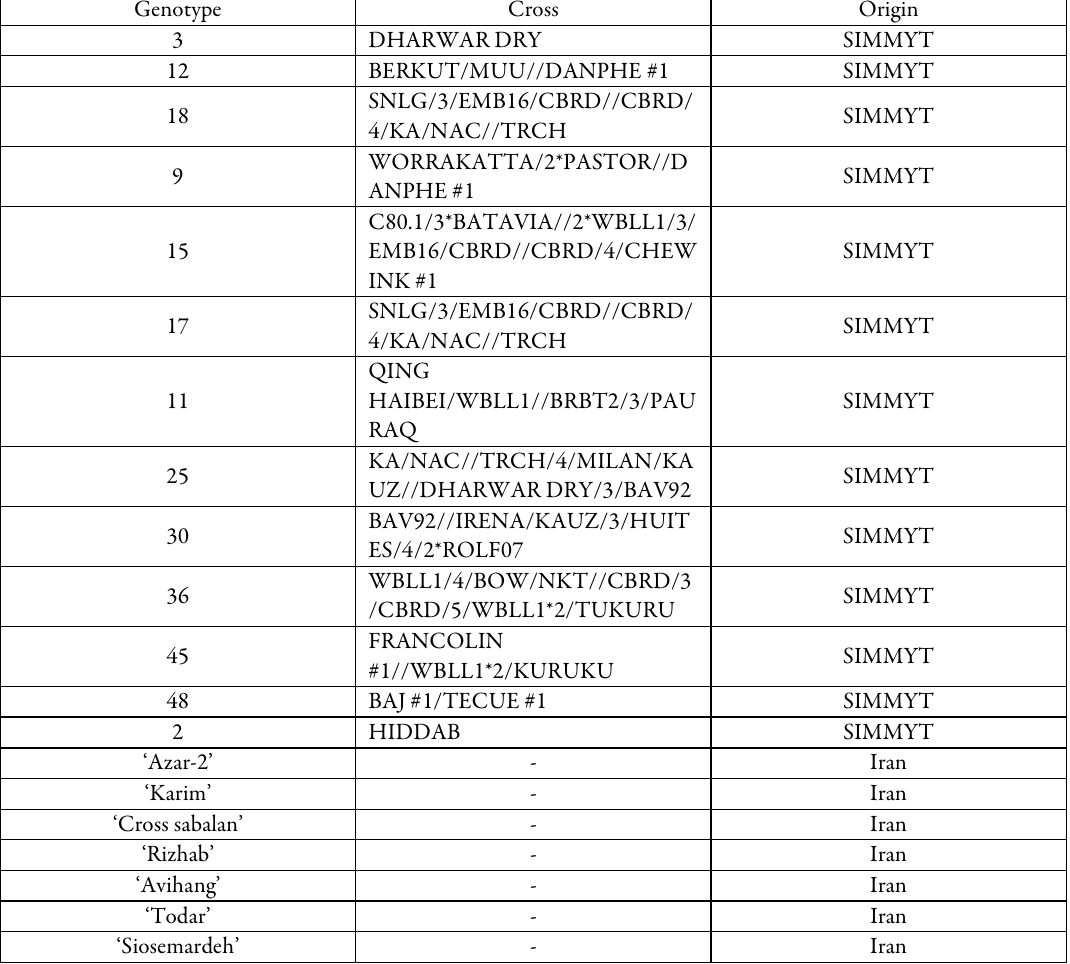
Table 1. Genotypes of rain-fed wheat used in this experiment Genotype